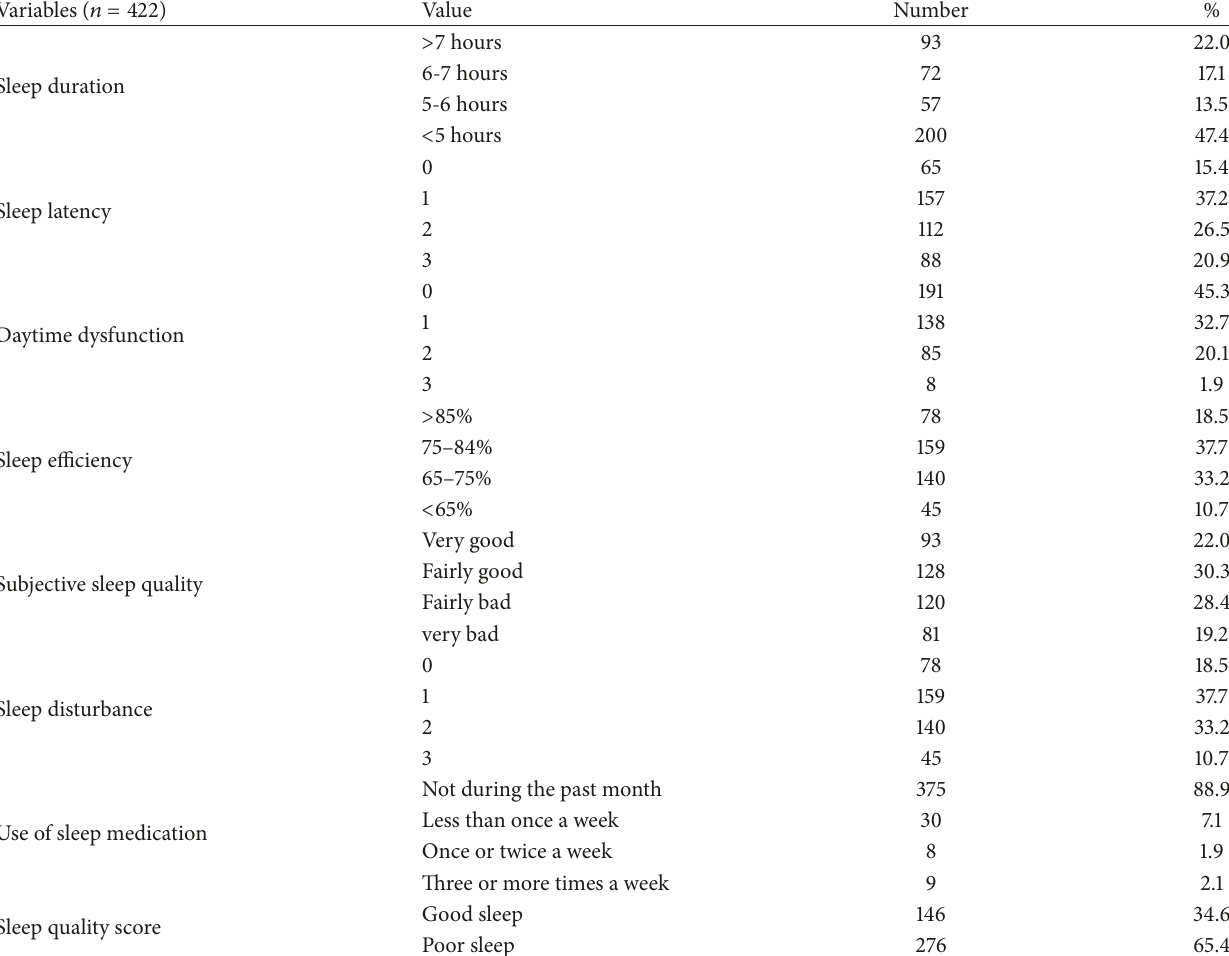
Table 2: Sleep quality and its components scores among adults in Jimma town, April